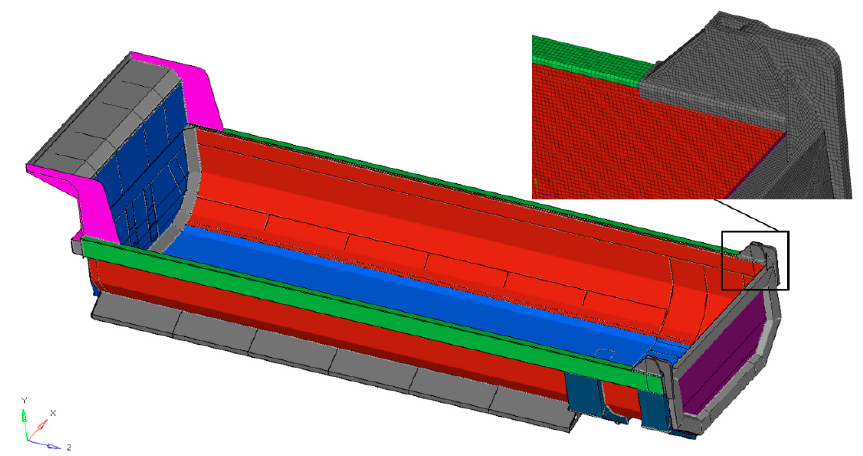
Figure 4. Finite element model of U- carriage.